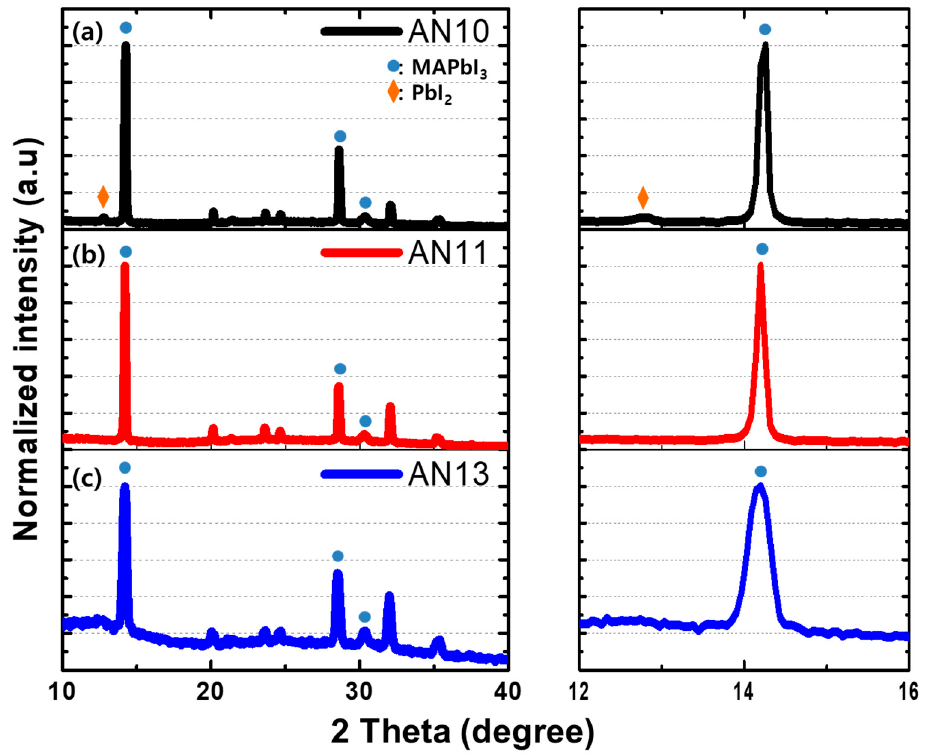
Figure 6. XRD patterns of the MAPbI 3 perovskite films on various PEDOT:PSS layers: ( a ) AN10, ( b ) AN11, and ( c ) AN13.